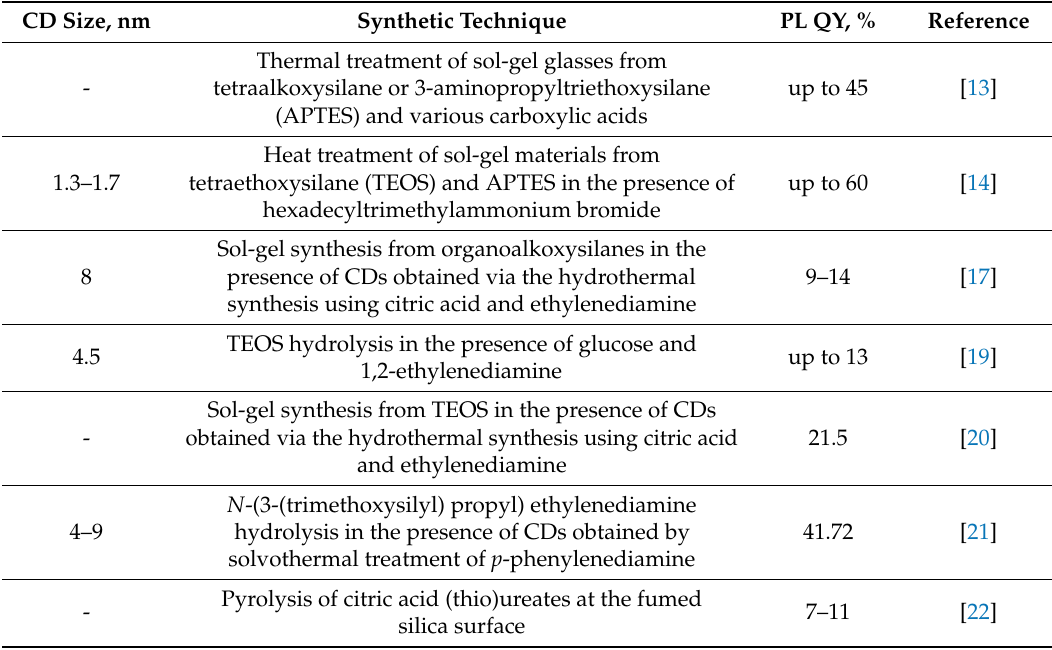
Table 2. Photoluminescent characteristics of carbon-containing silica-based materials synthesized by different